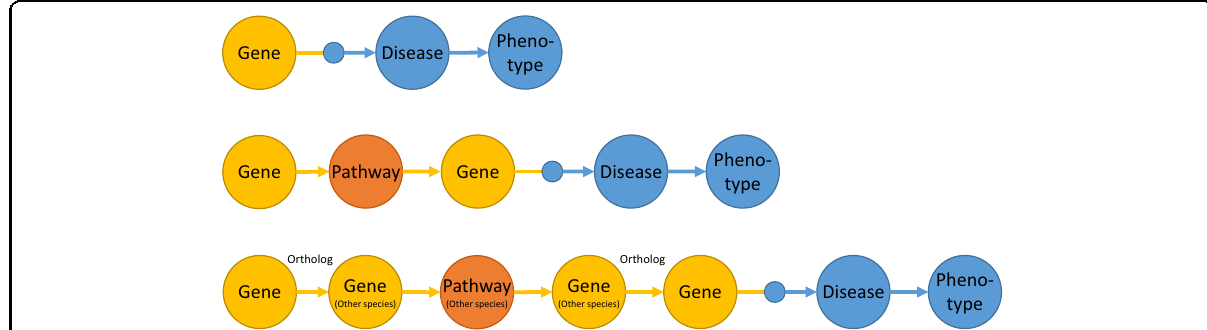
Fig. 1 Three different models used for prioritizing the associations of key EV genes with diseases. Top: A model that prioritizes diseases and phenotypes based on gene-disease associations known in the literature. Middle: This model predicts the associated diseases and phenotypes using molecular pathway associations. Bottom: This model predicts the associated diseases and phenotypes using orthologue molecular pathway associations in other